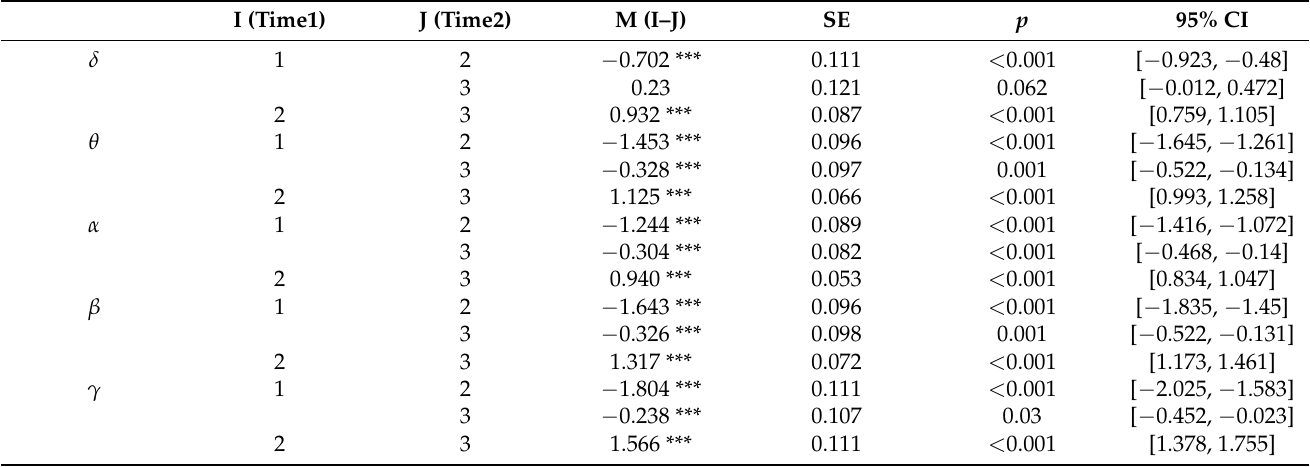
Table A7. Post-test results.